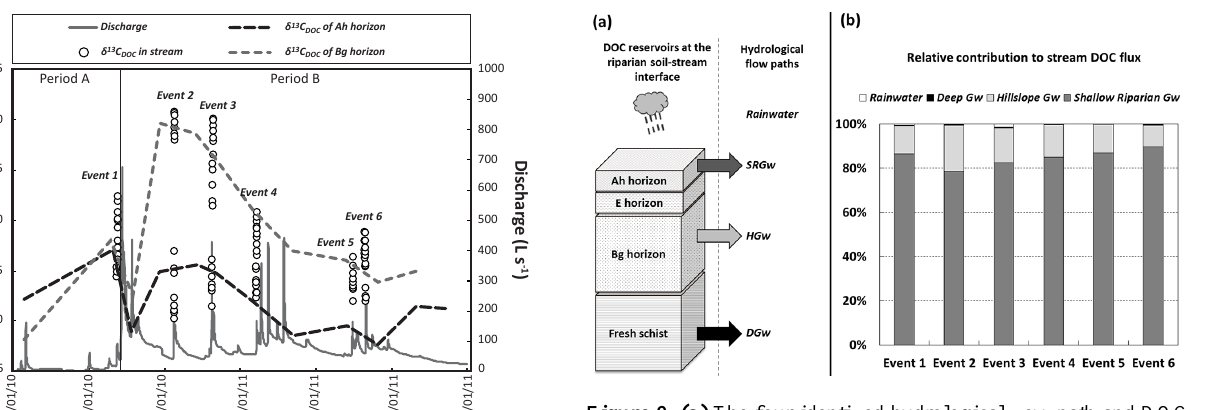
Figure 9. (a) The four identified hydrological flow path and DOC reservoirs at the riparian soil–stream interface and (b) Contribution of each hydrological flow paths to the total storm DOC flux as calcu- lated using the NO 3 , DOC, and SO 4 concentrations and the EMMA method. Note that DOC in wetland soil horizons is basically a mix- ture of wetland-borne and upland-borne